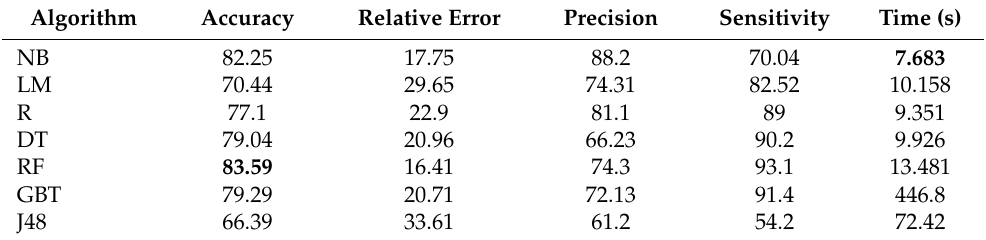
Table 7. Comparison between different algorithms applied on preprocessed M-health